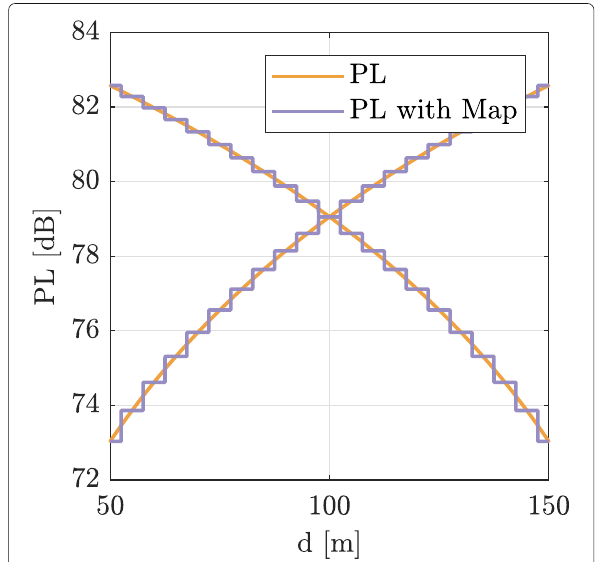
Fig. 14 Illustration of PL calculation with and without maps. In the underlying scenario, a user moves on the connecting line of two BSs. The distance between the BSs is 200m and the PL model is free space with a pathloss exponent of 2 at a frequency of 2.14GHz. The plot shows the respective PL values over the distance to the first BS. When using a PL map with a resolution of 5m / pixel there will be a region around the distance of 100 m where the user experiences the same PL from both BS, which leads to problems for cell association. With